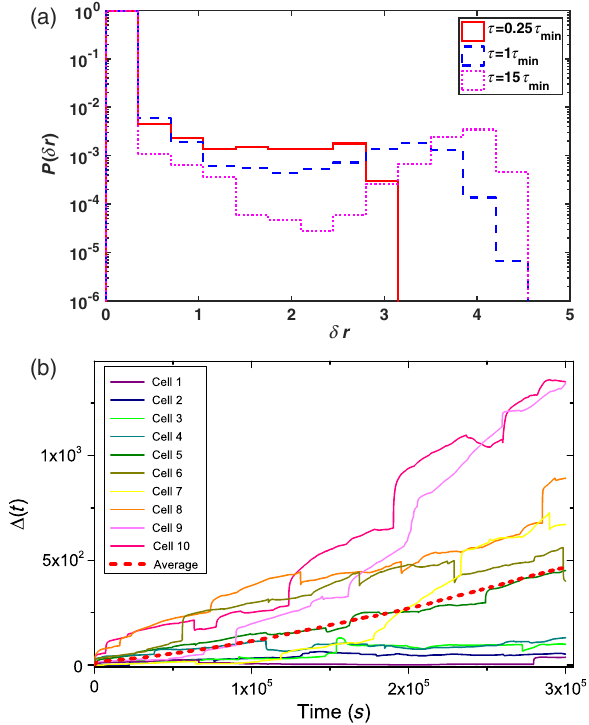
FIG. 12. Quantifying spatial heterogeneity in tumor cell growth. (a) Probability distribution of distance δ r (in units of μ m), moved by cells over δ t ¼ 100 , 400, and 6000 s, respectively, for varying average cell cycle time τ ¼ 0 . 25 τ , 1 τ , and min min 15 τ : δ t is normalized by τ to 0.0074. (b) Time-resolved squared min displacements Δ ð t Þ (in units of μ m 2 ) of individual cells in a ). The average, shown as a model for a growing tumor ( τ ¼ τ min dashed line for approximately 800 such individual trajectories, is not meaningful because of dynamic heterogeneity.